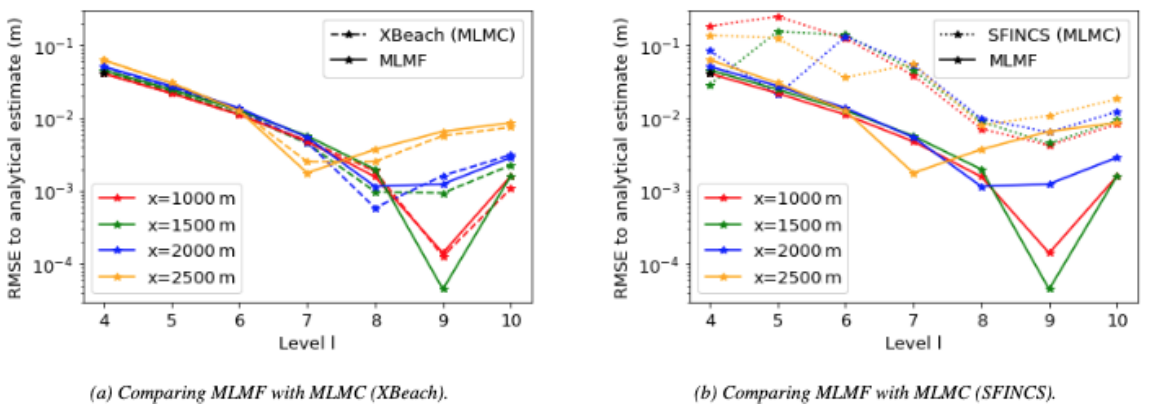
Figure 6. Error (RMSE) with respect to the analytical estimate for the final water elevation at the locations of interest in the non-breaking wave test case, as the resolution level becomes finer. The x axis indicates the finest level considered by the MLMC and MLMF estimators for that error, and both the error from using MLMF and the error from using MLMC with a single model are shown. Here a tolerance of (cid:15) = 1 × 10 − 3 is chosen in Eqs. (B7) and (14) for MLMF and MLMC respectively.